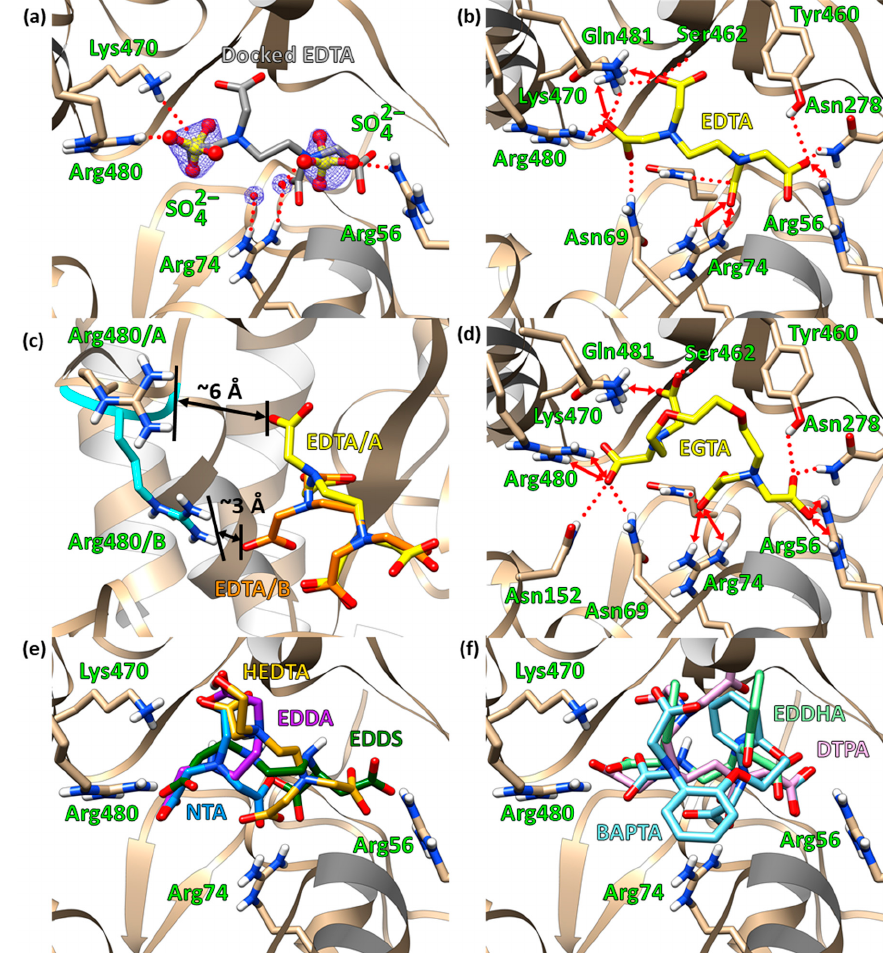
Figure 5. Ligand-binding pocket of EppA. In ( a ), ( b ), and ( d ), hydrogen bonds are depicted by red dotted lines and salt-bridging interactions are depicted by red double-headed arrows; these intermolecular interactions are omitted for clarity in panels ( c ), ( d ), and ( f ). EDTA, EGTA, and residues responsible for these interactions are labeled and shown as sticks; the polypeptide backbone is shown as a ribbon diagram. For all panels, tan (for the protein; ligands are otherwise specified) sticks are carbons, red are oxygens, blue are nitrogens, and white are hydrogens. ( a ) Docked EDTA (gray) superposed onto crystallographic sulfates (yellow and red ball and sticks) that were identified in the F o -F c maps of both the tetragonal and orthorhombic structures. The sulfates are shown with their corresponding electron density (blue mesh) contoured at 1.5 σ . ( b ) EDTA (yellow) docked into EppA’s ligand-binding cleft. ( c ) Comparison of EDTA docked into the binding pocket of EppA with the loop containing Arg480 in one of its two conformers. The distances show that in Conformer A, hydrogen bond formation is not possible and electrostatics are weak, whereas Conformer B has more favorable electrostatics and is closer to being within range for hydrogen bonding. ( d ) EGTA (yellow) docked. ( e ) Superposition of docked EDDA (purple), EDDS (forest green), HEDTA (gold), and NTA (sky blue). ( f ) Superposition of docked BPTA (pastel blue), DTPA (magenta), and EDDHA (lime